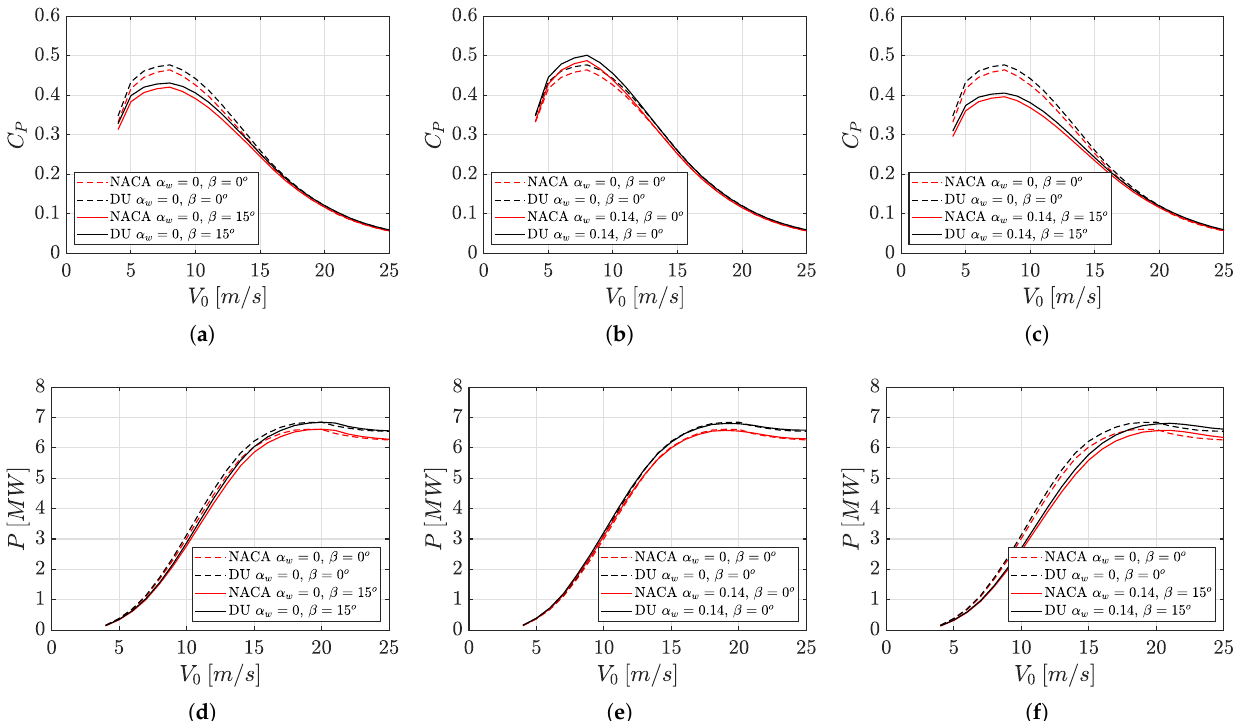
Figure 15. DeepWind 5 MW power coefficient and power with varying:(1) Airfoil ( a , d ); (2) Wind shear coefficient ( b , e ); (3) Rotor tilt ( c , f